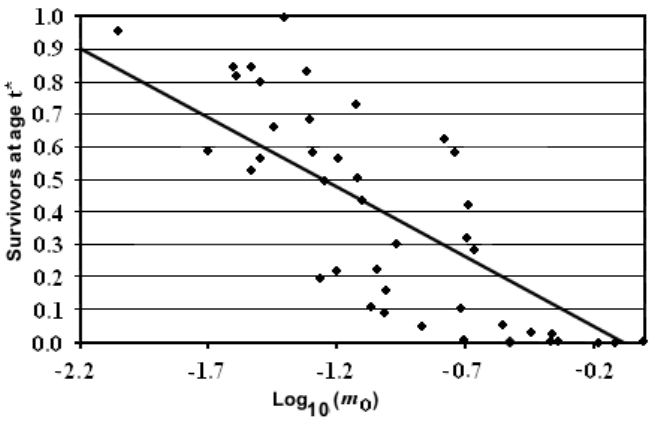
FIGURE 7. Inverse significant correlation (linear regression, r = –0.820448404, t = –9.519054012, p < 0.001) between log 10 ( m 0 ) and the survivors at age t* when the total increment of mortality ( m i ) becomes greater than m 0 . The relation has been calculated using the same data as in Fig. 5. Correlation is significant as well for mammals and birds considered separately. Substituting log 10 ( m 0 ) with m 0 , statistical analysis gives r = –0.659414466, t = –5.818275394, p <